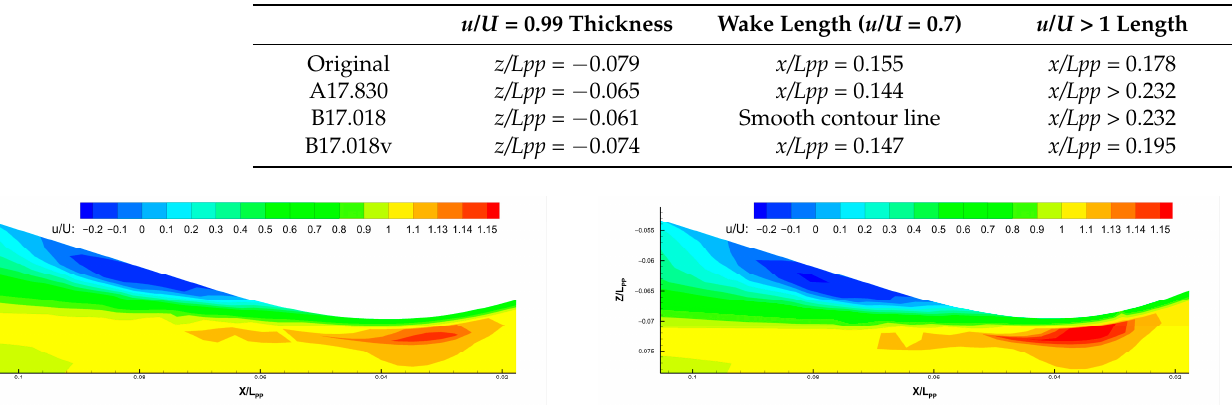
Figure 12. Lowest and highest axial velocity around sonar dome (left: B17.018; right: B17.018v). Table 8. Maximal and minimal C P , and the difference between them ( ∆ C P ) on bow surfaces. Maximal C P